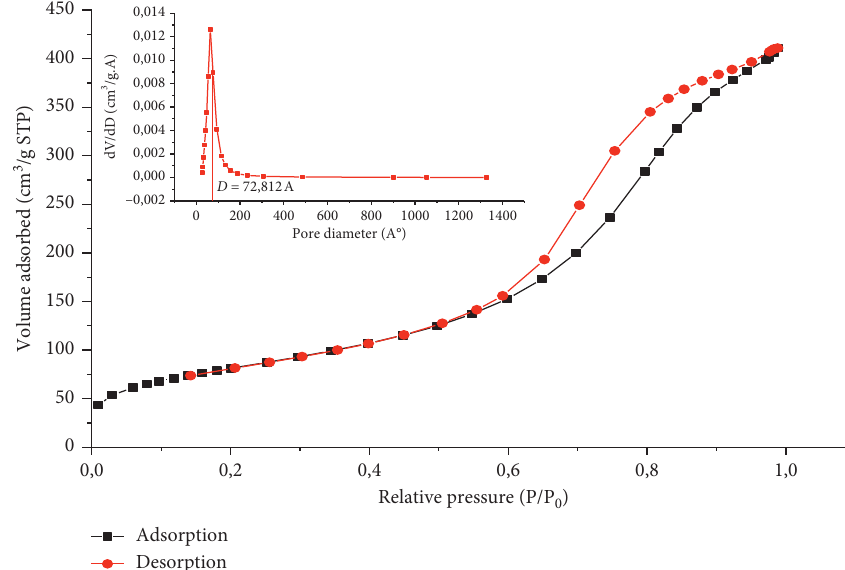
Figure 5: N 2 adsorption/desorption isotherms of Gh-B.